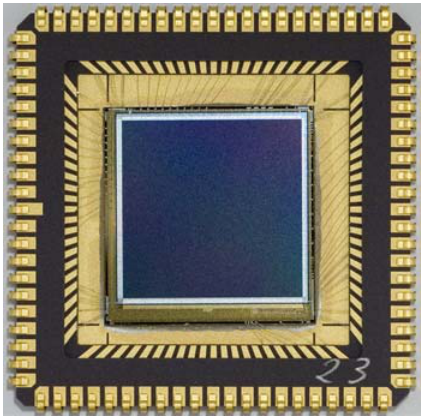
Figure 6. Chip Photo of the APS for star sensor with TFC layer and top contact (metal